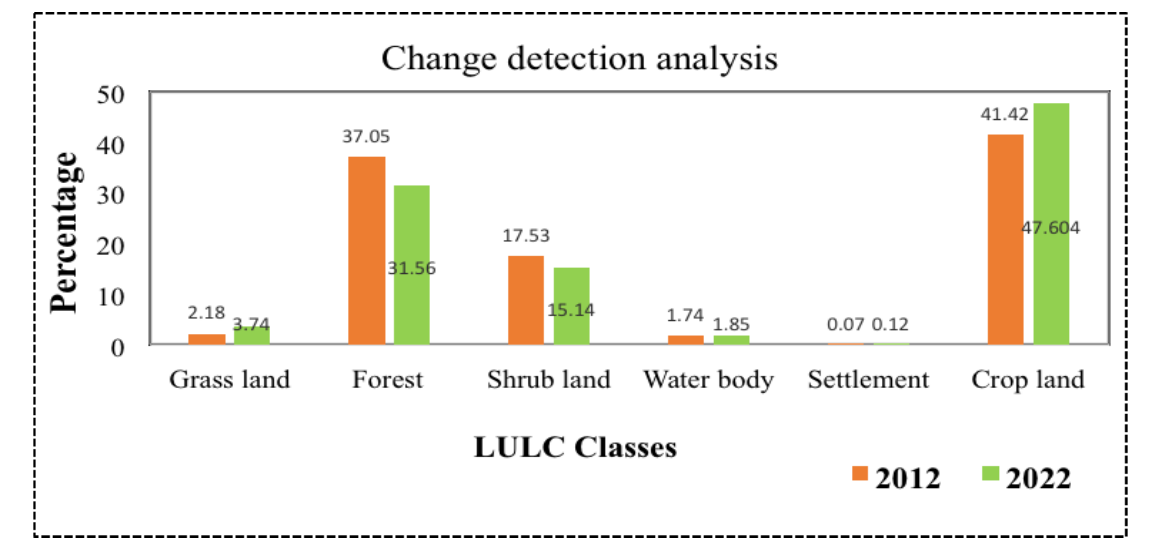
Figure 3. Change in LULC types between 2012 and 2022.